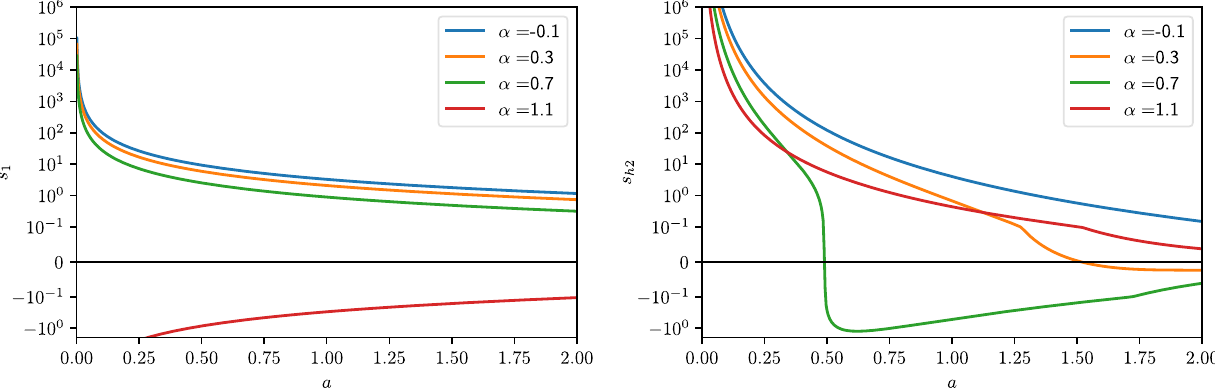
Fig. 2 Model M 2 : s 1 and s h 2 as function of scale factor for some values of α . We have used a mixed log-linear scale in order to view both asymptotic behaviour and zero